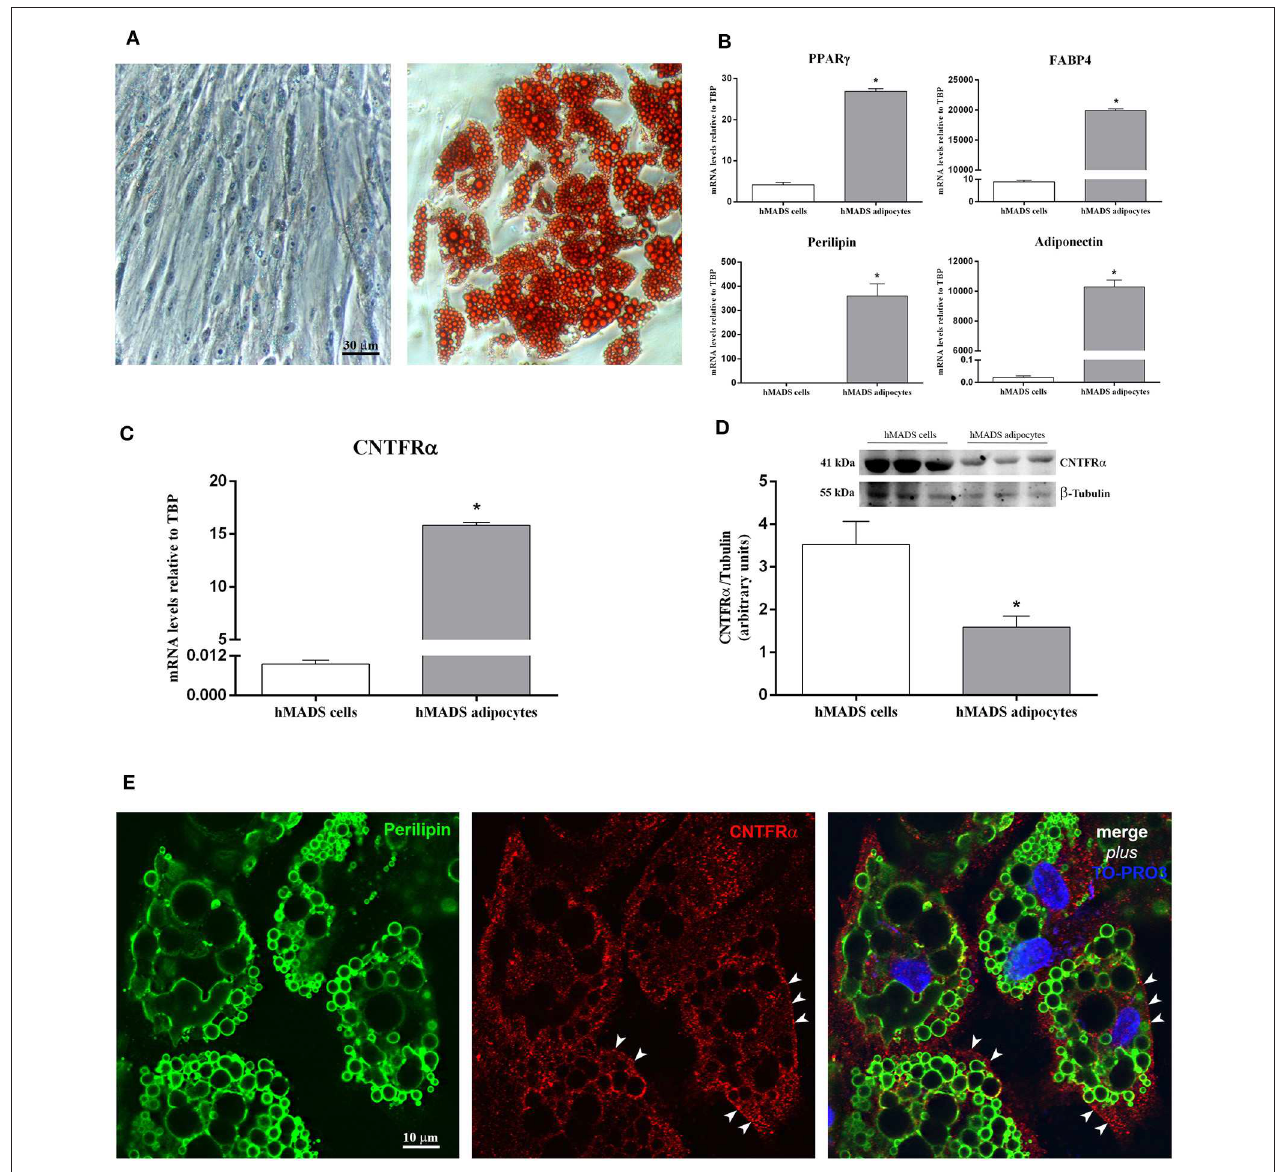
FIGURE 1 | CNTFR α expression in undifferentiated cells and differentiated hMADS adipocytes. (A) Representative pictures from Oil Red O-stained confluent hMADS cells (day 0, left panel) and adipocytes (day 13, right panel). Data were analyzed using Student’s t -test. (B) qRT-PCR analysis of PPAR γ , FABP4, perilipin, and adiponectin expression in hMADS cells (white bars) and adipocytes (gray bars). Data ( n = 3) are mean ± SEM, * p < 0.05 compared with hMADS cells. Data were analyzed using Student’s t -test. qRT-PCR (C) and representative immunoblot and quantification (D) of CNTFR α expression in hMADS cells (white bars) and adipocytes (gray bars). Data ( n = 3) are mean ± SEM, * p < 0.05 compared with hMADS cells. Data were analyzed using Student’s t -test. (E) hMADS adipocytes: double immunostaining and confocal microscopy images showing perilipin staining (left, green) around lipid droplets and CNTFR α staining (middle, red) in